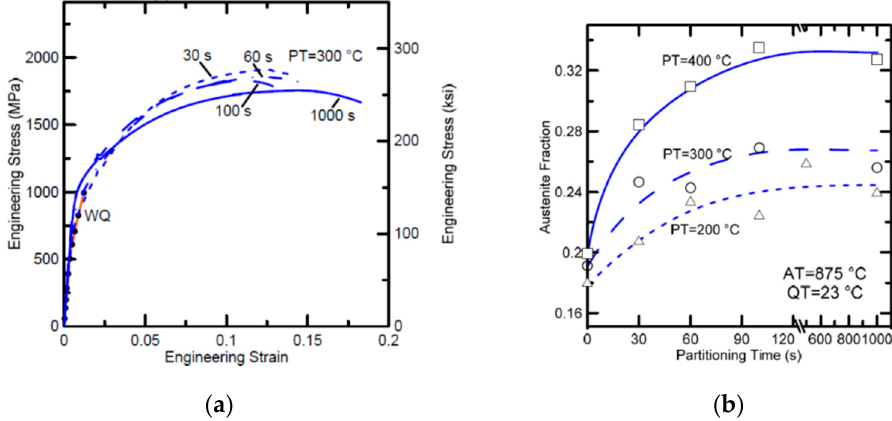
Figure 6. Quenching and partitioning (Q&P) response of 0.25 C, 8.23 Mn, 1.87 Si, 0.05 Ni, 0.24 Mo (wt. pct.) steel. ( a ) Tensile stress-strain results after quenching to room temperature and partitioning at 300 °C for times indicated. ( b ) Evolution of austenite fraction during partitioning at temperatures indicated [21].